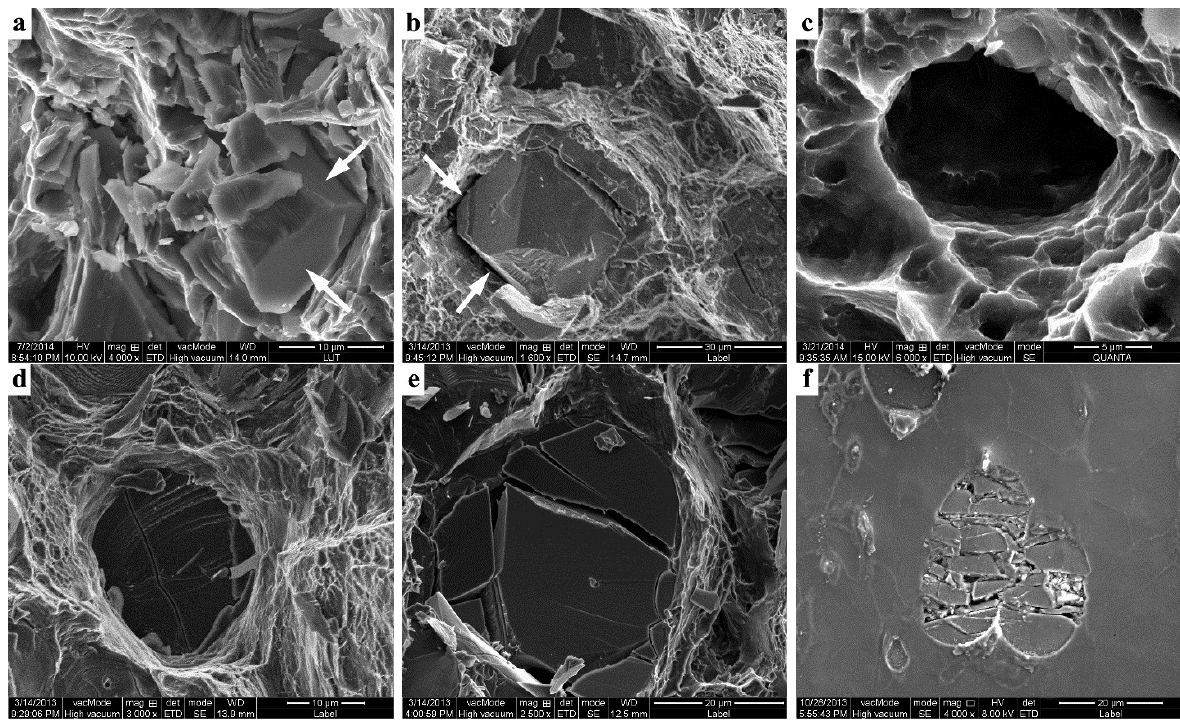
Figure 6. Typical SEM images showing Mg 2 Si particles in: ( a ) as-cast composite; ( b – e ) the thixoforged composite fracture surface; ( f ) the thixoforged composite tensile